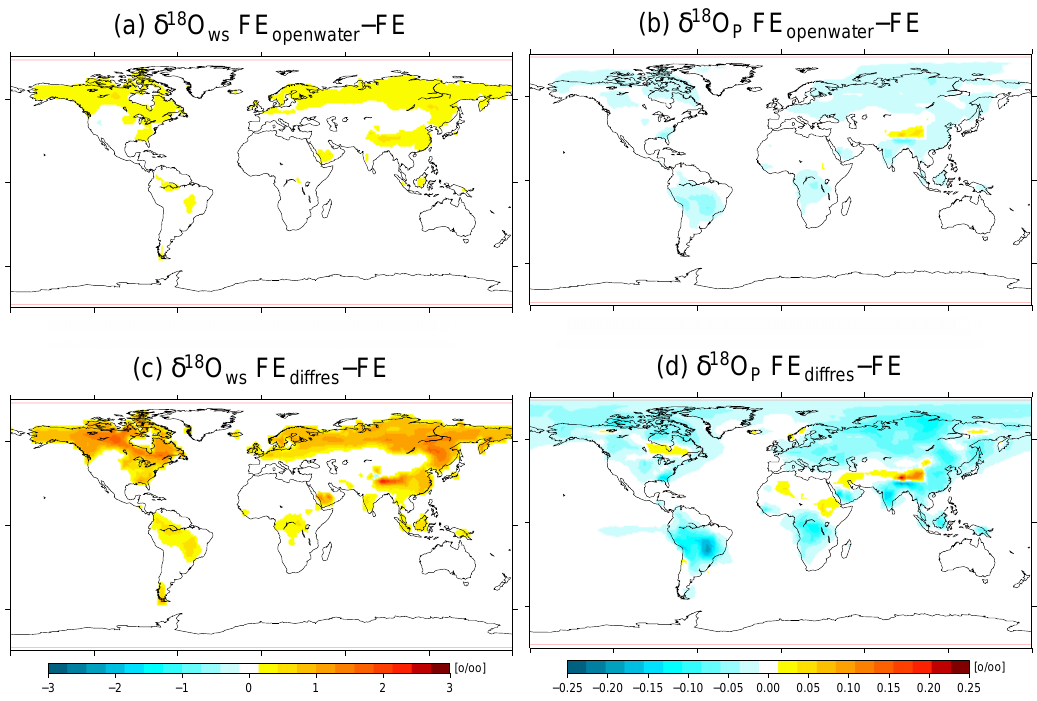
Fig. 13. Annual mean value of the simulated anomaly of δ 18 O ws for (a) FE openwater -FE and (c) FE diffres -FE, and of δ 18 O P for (b) FE openwater -FE and (d) FE diffres -FE.